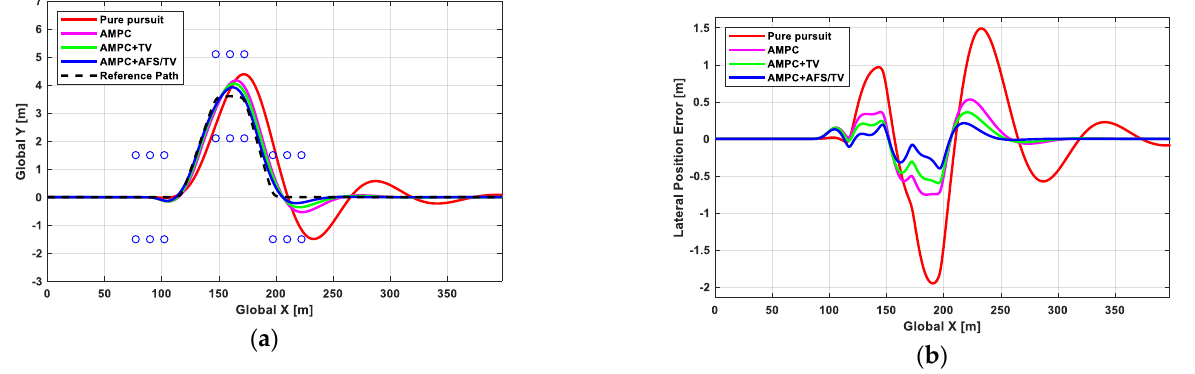
Figure 6. ( a ) Vehicle trajectory and ( b ) lateral position error.